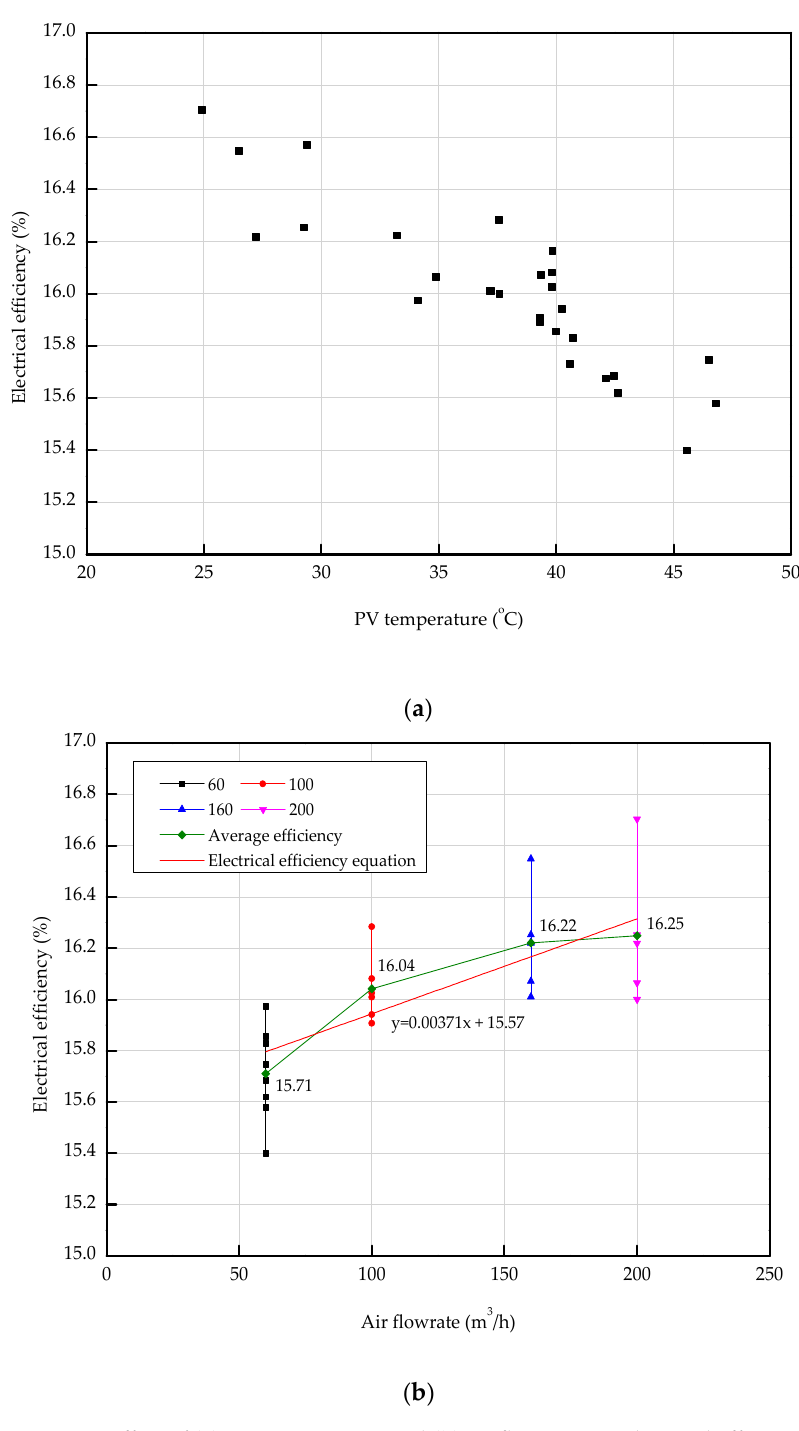
Figure 11. E ff ect of ( a ) PV temperature and ( b ) air flow rate on electrical e ffi Figure 11. Effect of ( a ) PV temperature and ( b ) air flow rate on electrical efficiency.